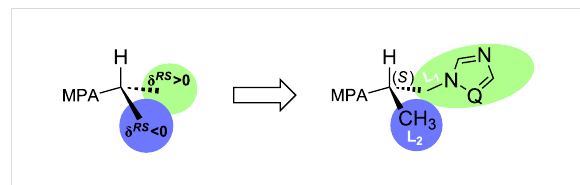
to significant differences in chemical shifts ( δ = 0.91